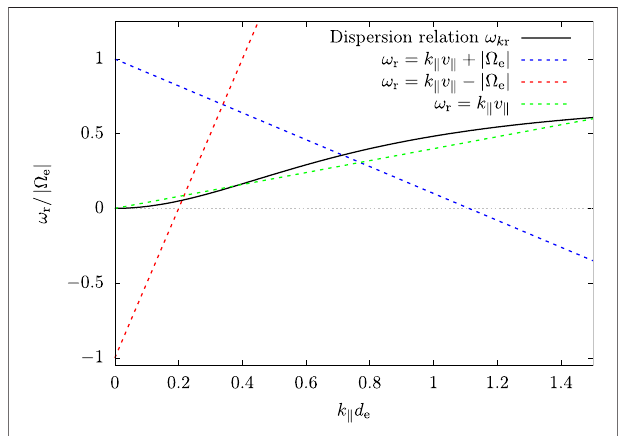
FIGURE 2 | Dispersion relation and resonance conditions. The black curve shows a solution to Eq. 9 for the fast-magnetosonic/whistler wave. We assume an angle of 40 ° between k and B 0 and a very cold plasma ( β j = 10 − 8 ) consisting of Maxwellian protons and electrons. For our de fi nition of β j , see Eq. 22 . The dashed lines represent electron resonance conditions according to Eq. 16 for different n and v (cid:2) . The wavenumber is normalised by the inverse of the electron inertial length d